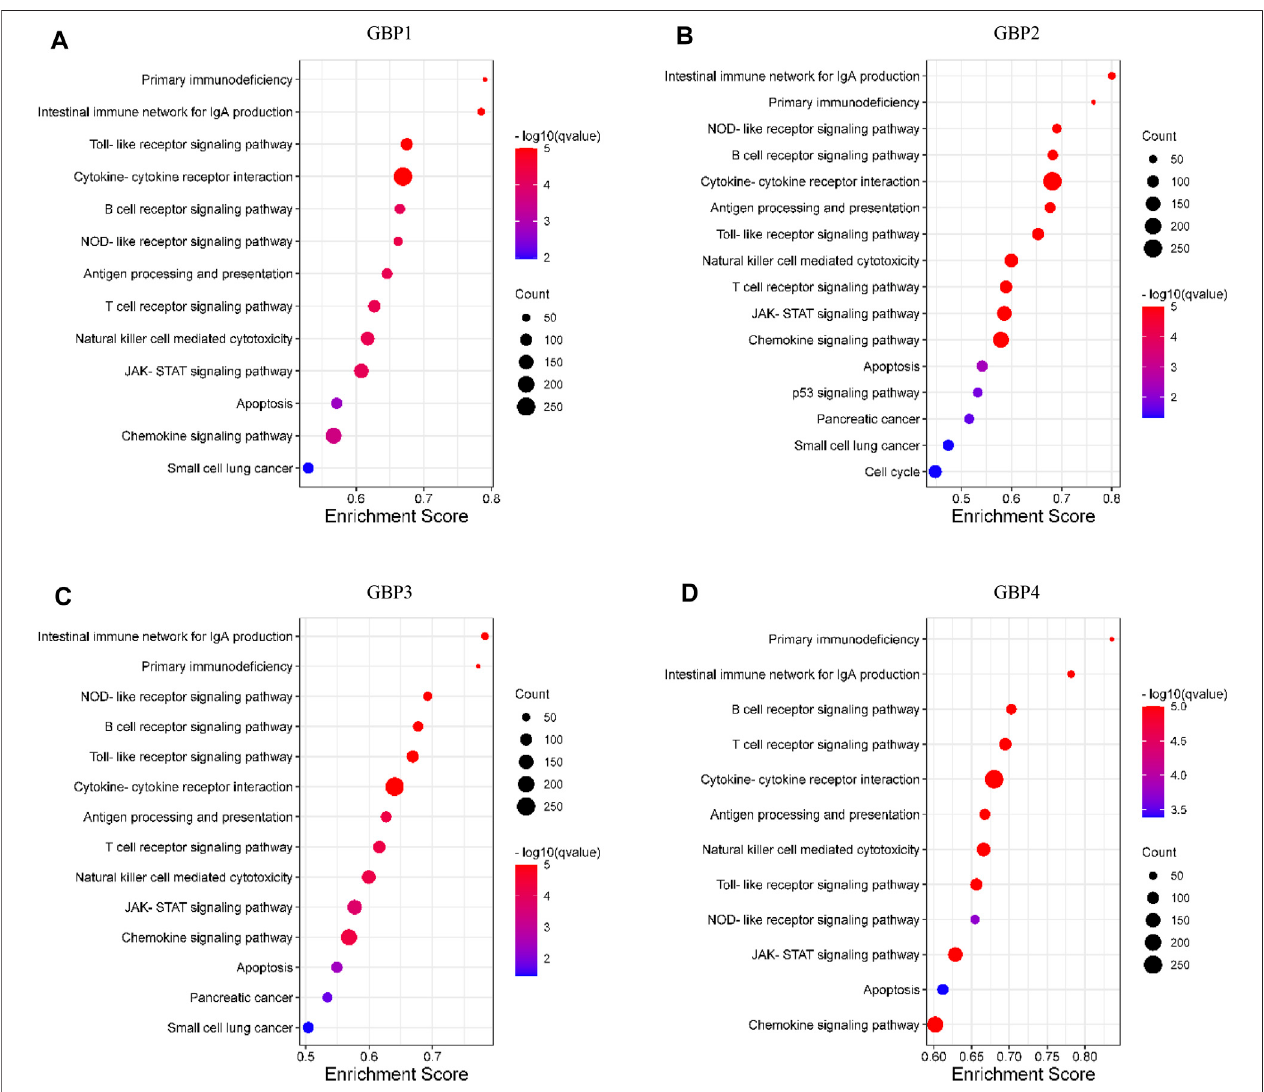
FIGURE8| PathwayenrichmentanalysisofGBP1,2,3,4inLGG.Thebubblediagramdisplayedthegenesetenrichmentanalysis(GSEA)resultsinthephenotype high group of (A) GBP1 (B) GBP2, (C) GBP3, and (D) GBP4 in LGG. The nominal p -value (NOM p < 0.05) and false discovery rate (FDR q < 0.05) were used to select signi fi cantly enriched gene